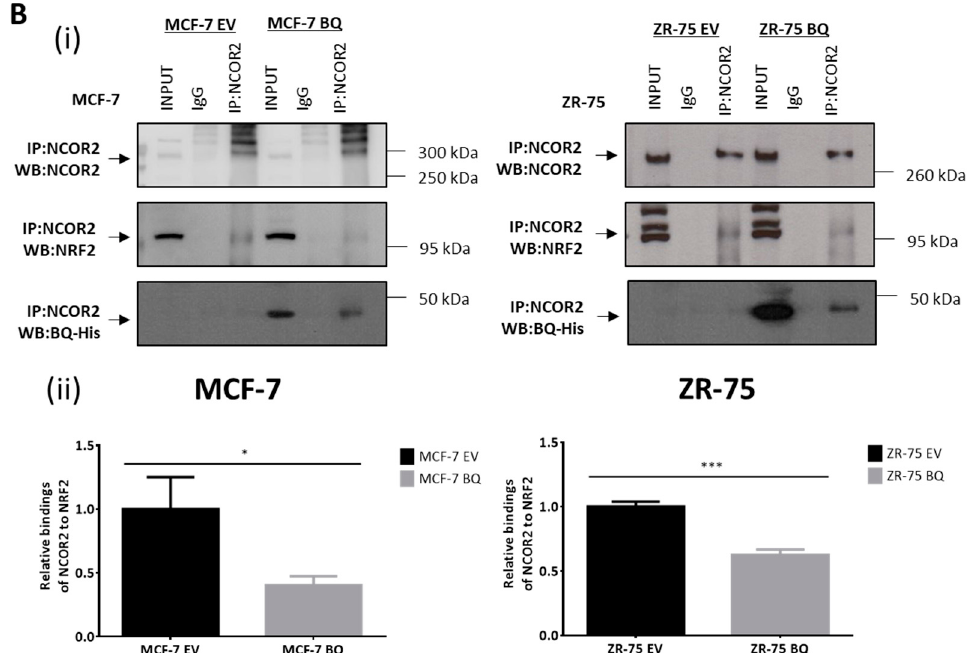
Figure 7. NCOR2 suppresses transcriptional activity of antioxidant response element (ARE) while BQ modulates this effect. ( A ) The effect of NCOR2 and BQ on the activity of ARE was examined by luciferase assay. Luminescence readings were normalized to renilla luciferase activity (as transfection efficiency control). The data were presented as % change of luciferase activity with reference to empty vectors control cells (i.e., BQ and NCOR2 negative). Bars showed as mean ± SD. (Student’s t -test, * p < 0.05; ** p < 0.01) (N = 3) ( B ) The effect of BQ overexpression on the protein interaction between NRF2 and NCOR2. Co-immunoprecipitation was employed to determine the protein–protein interaction. BQ overexpressing cells and control cells were harvested for immunoprecipitation by anti-NCOR2 antibody (IP: NCOR2). Whole cell lysates were used as input. Normal rabbit Immunoglobulin (IgG) was used as pull-down control. ( i ) Immunoblotting by anti-NCOR2, anti-NRF2 and anti-His antibodies were shown. Corresponding bands were indicated by arrows. The intensities of the NRF2 band were quantified by ImageJ software. ( ii ) Bars shown relative bindings of NCOR2 to NRF2 at protein level, presented as mean ± SD. (Student’s t -test, * p < 0.05; *** p < 0.001). (N = 3).